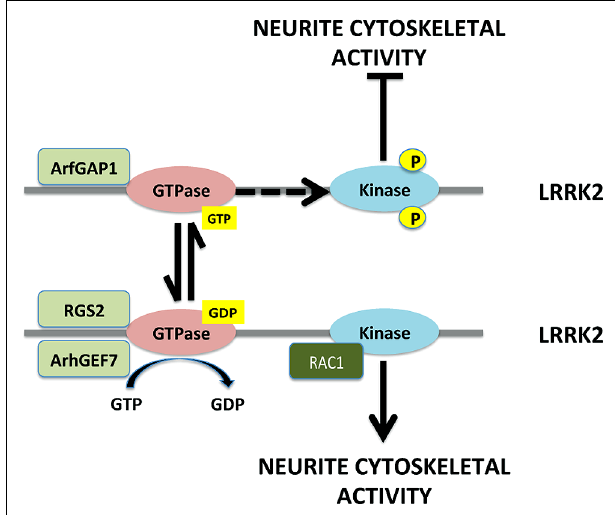
FIGURE 1 | Regulation of LRRK2 output by GTPase activity, GAPs and GEFs. RGS2 and ArhGEF7 both bind to LRRK2 and inhibit GTPase activity, which also inhibits LRRK2 kinase activity and appears to direct LRRK2 toward increasing neuronal cytoskeletal activity. Rac1 is a small GTPase known to regulate actin polymerase. Rac1 binds to LRRK2 and might act in concert with LRRK2 to increase cytoskeletal activity. In contrast, binding of ArfGAP1 to LRRK2 increases its autophosphorylation, which appears to inhibit cytoskeletal